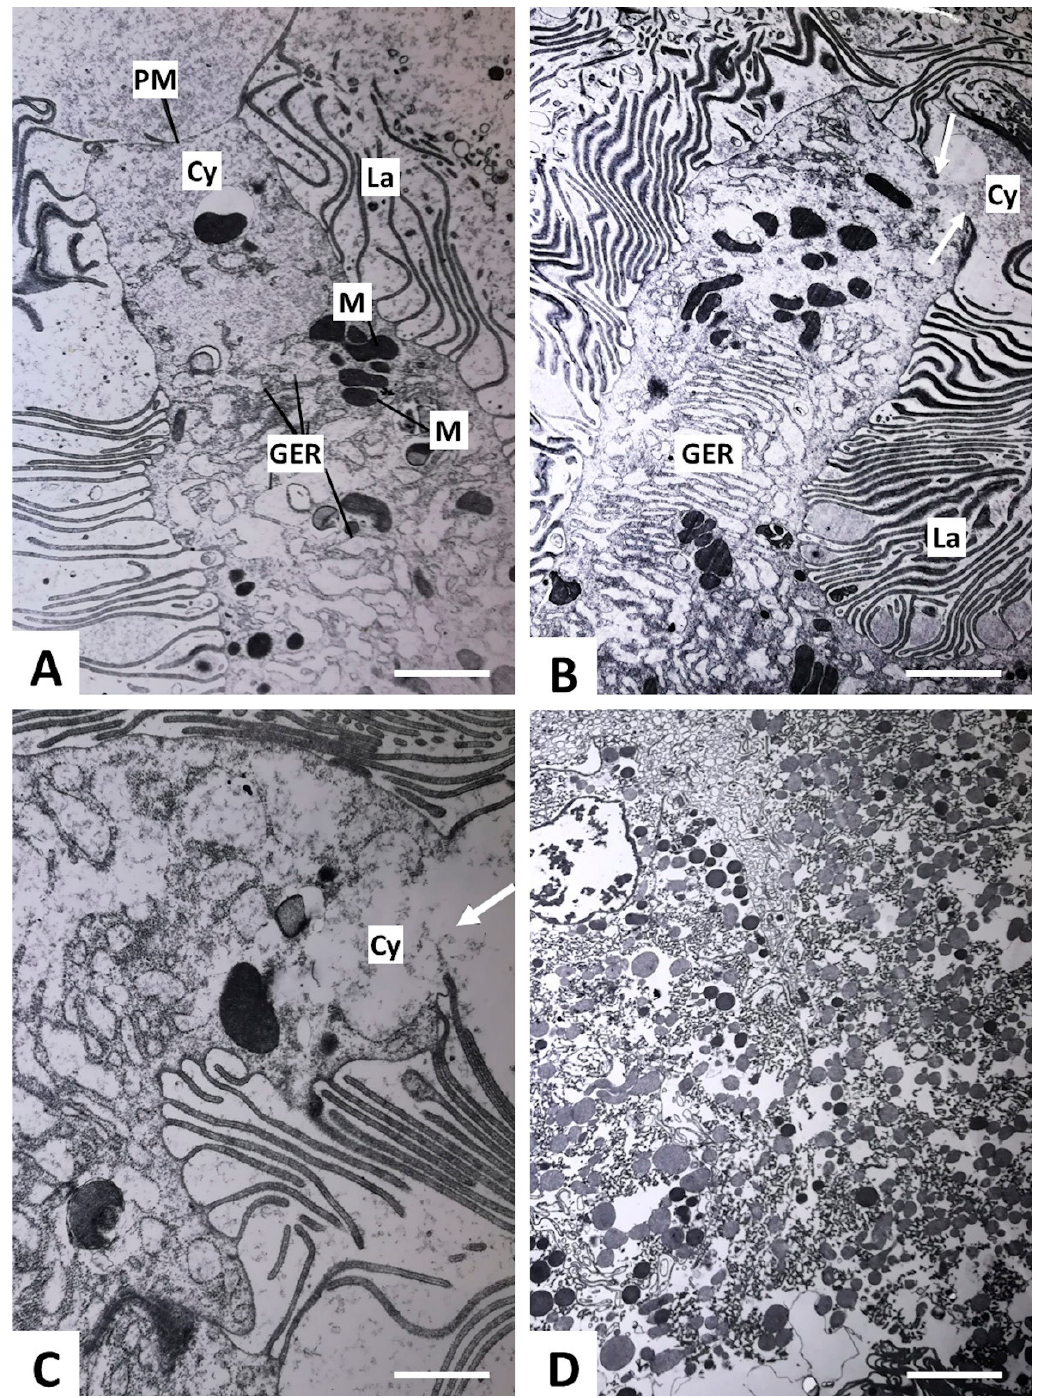
Figure 3. Transmission electron micrographs showing progressive breakdown of the gastrodermal cells of adult F. hepatica . ( A ) The apex of a columnar gastrodermal cell. The lamellae (La) are spaced far apart, and the apical plasma membrane (PM) appears very thin. ( B ) The apical plasma membrane is broken (arrows) and the cell has begun to leak apical cytoplasm (Cy) into the gut lumen. ( C ) High- power image of a break (arrow) in the apical plasma membrane. ( D ) An array of membrane fragments, mitochondria, and vesicles are released into the gut lumen. GER, granular endoplasmic reticulum; M, mitochondria. Scale bars: 5 µ m ( A , B ), 2.5 µ m ( C ), and 10 µ m ( D